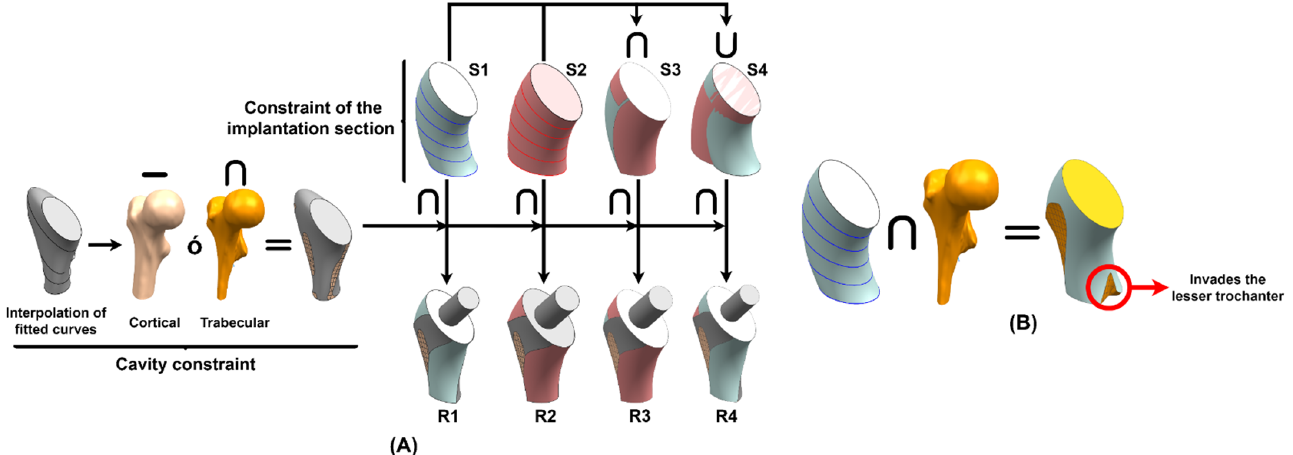
Figure 7. Assessment of implantability ( A ) without and ( B ) with the trabecular bone.